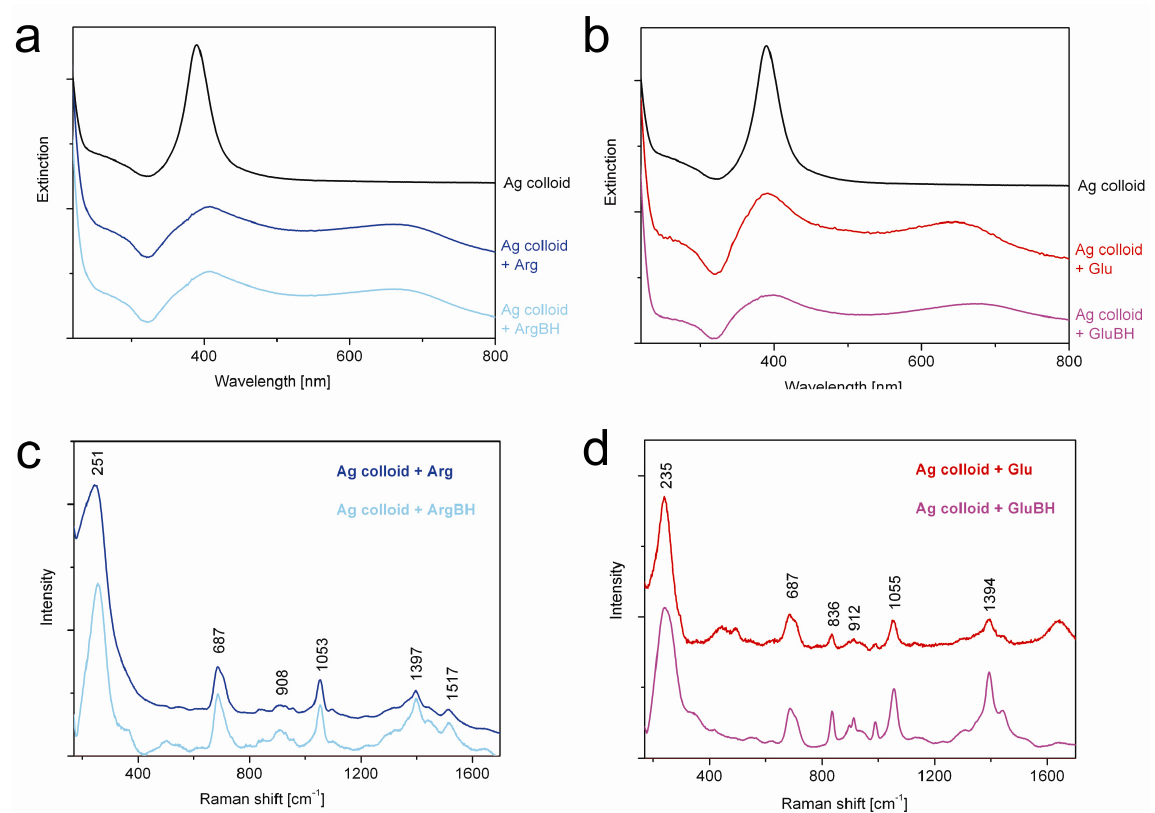
Figure 5. ( a ) Surface plasmon extinction (SPE) spectra of Ag colloid without and with Arg and/or ArgBH; ( b ) SPE spectra of Ag colloid without and with Glu and/or GluBH; ( c ) SERS spectra of Ag colloid with Arg and/or ArgBH; ( d ) SERS spectra of Ag colloid with Glu and/or